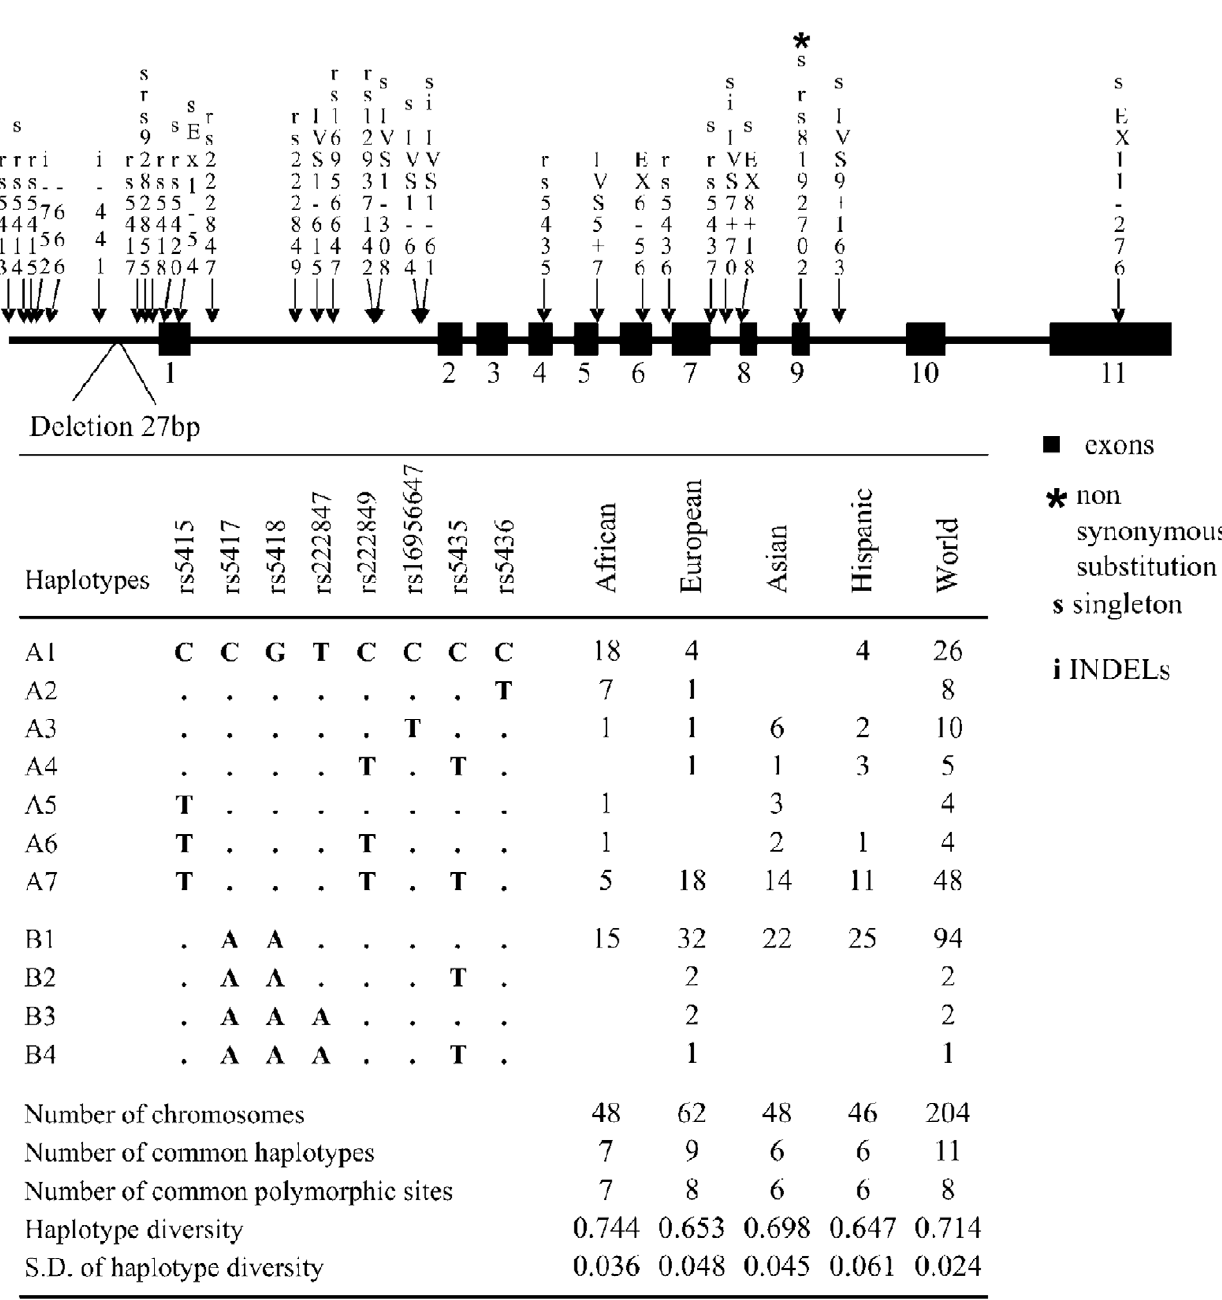
following scenarios: (a) an exponential growth that started at least 2400 generations ( , 60000 years) ago from the 0.001% of the current population size and (b) with a very recent expansion ( , 200 generations, , 5000 years) from the 0.0001% of the current